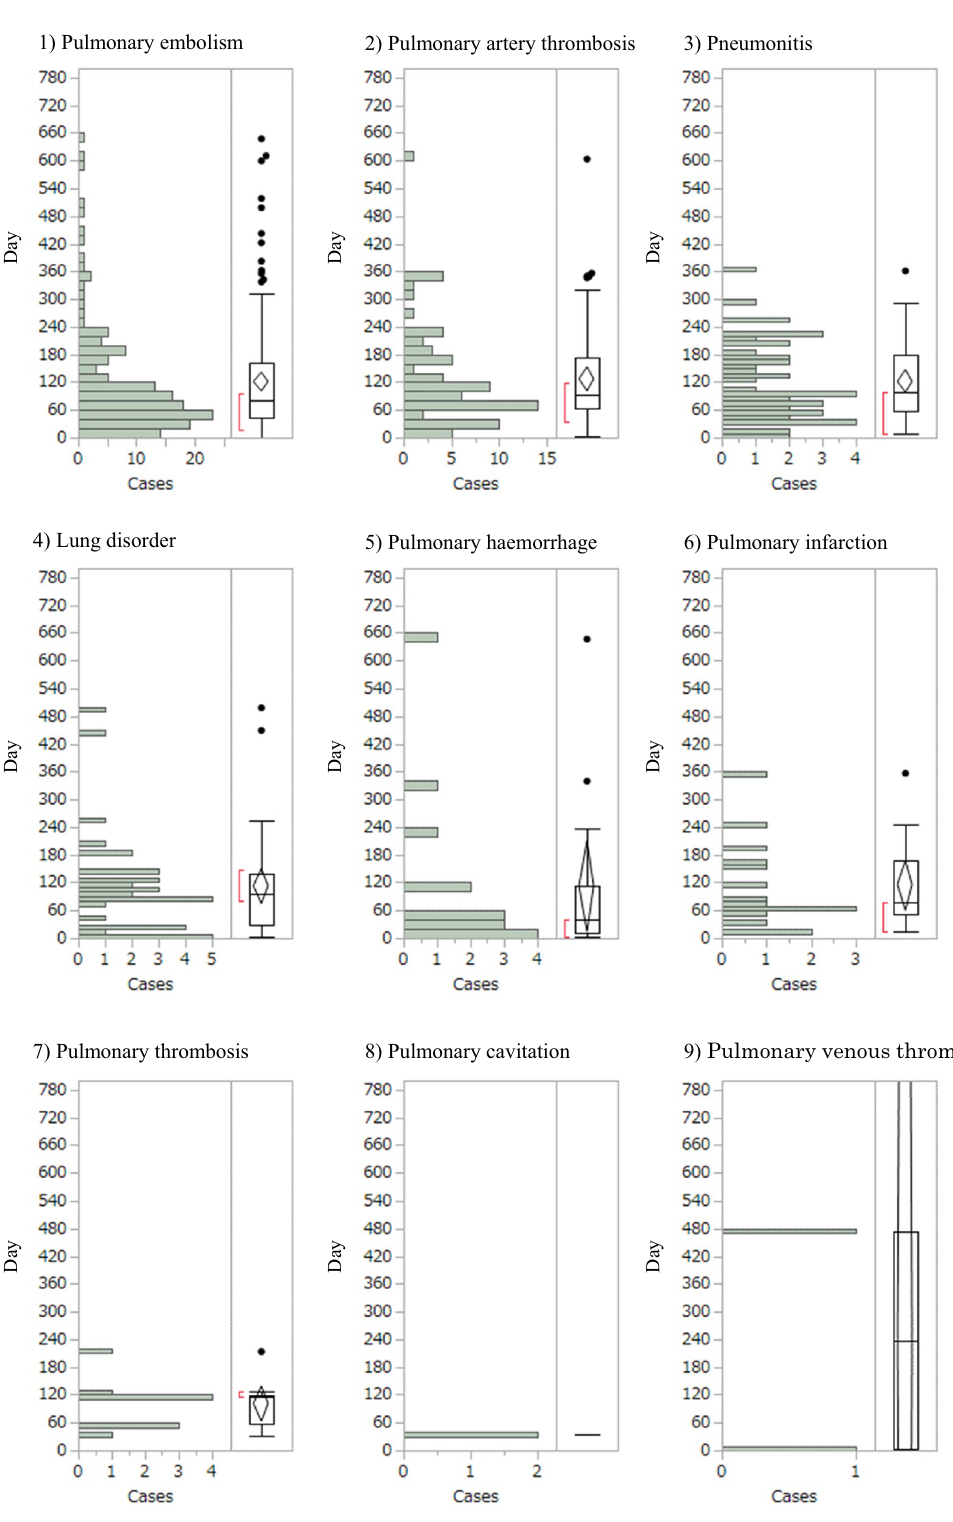
Figure 2. Histogram of lung toxicity for: (1) pulmonary embolism; (2) pulmonary artery thrombosis; (3) pneumonitis; (4) lung disorder; (5) pulmonary haemorrhage; (6) pulmonary infarction; (7) pulmonary thrombosis; (8) pulmonary cavitation; and (9) pulmonary venous